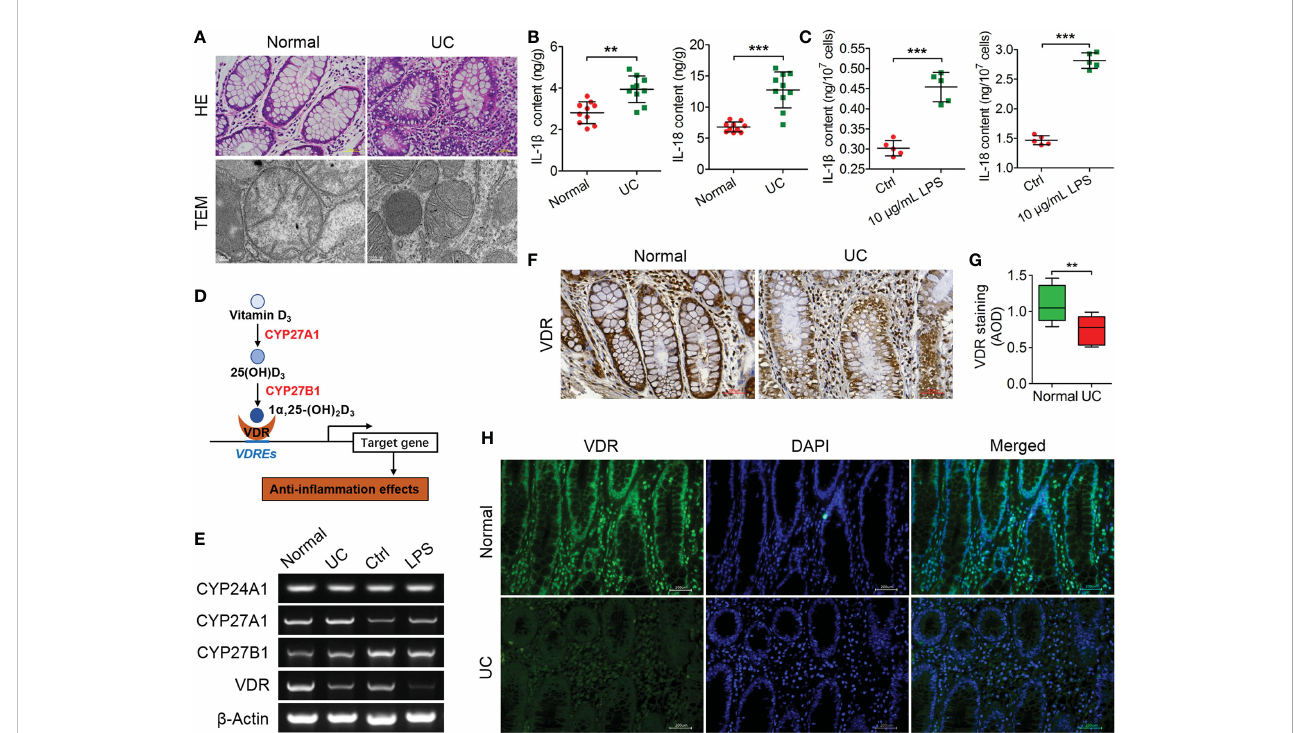
FIGURE 1 VDR is negatively correlated with in fl ammation in UC patients. (A) The pathological features of colitis are depicted by HE staining and TEM observation. (B, C) The contents of IL-1 and IL-18 were analysed through ELISA in UC tissues (B) and LPS-treated cells (C) . (D) Schematic diagram illustrating the key factors (CYP27A1, CYP27B1, VDR and CYP24A1) involved in the anabolism and catabolism of 1 a ,25(OH) 2 D 3 and the regulation of target genes. (E) qPCR was used to analyse the mRNA expression of CYP24A1, CYP27A1, CYP27B1 and VDR in colon tissue from UC patients and LPS-treated MIECs. (F, G) Representative Immunohistochemical images (F) and quanti fi ed data (G) for VDR in colons from normal and representative UC patients. (H) The expression of VDR was measured by immuno fl uorescence assay in colon sections from normal and representative UC patients. The data are shown as the means ± SD; n ≥ 3, ** P < 0.01 , *** P